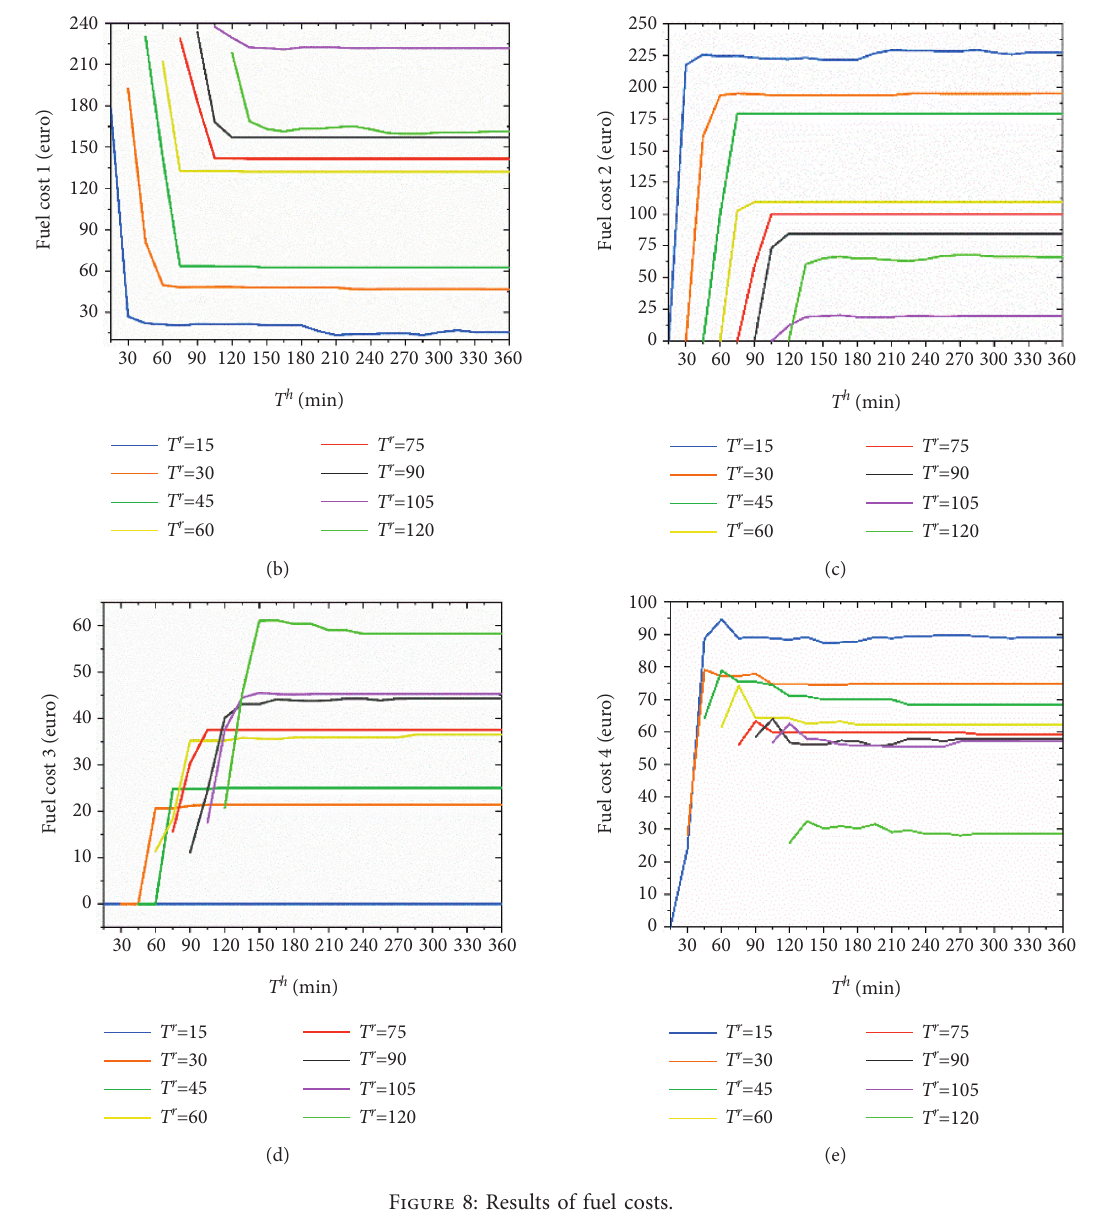
Figure 8: Results of fuel